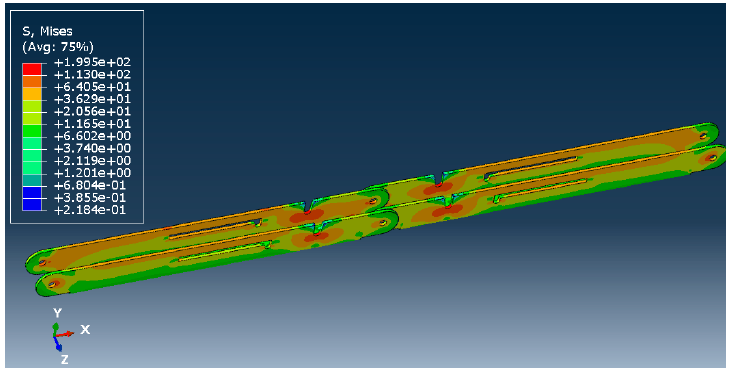
Figure 28. Von Mises Stress (MPa) of primary folding link bars (factored gravity load of 4 kPa).